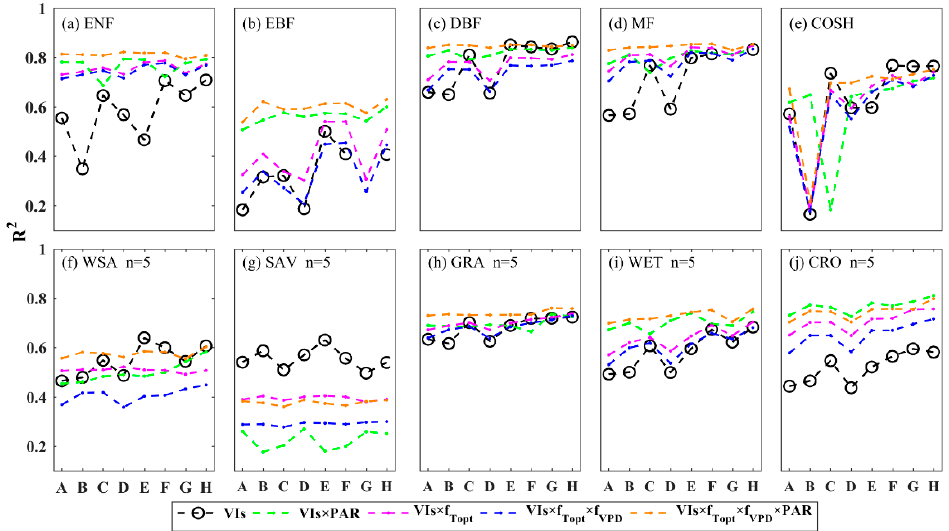
Figure 10. The plot of the averaged R 2 values for the relationships of the GPP with VIs combined with environmental factors (f Topt and f VPD and PAR) for each biome. The letters on the x axis stand for: A - NDVI, B - EVI, C - EVI2, D - NDVI BRDF , E - EVI BRDF , F - EVI2 BRDF , G - NIR V , and H - NIR V, BRDF . The